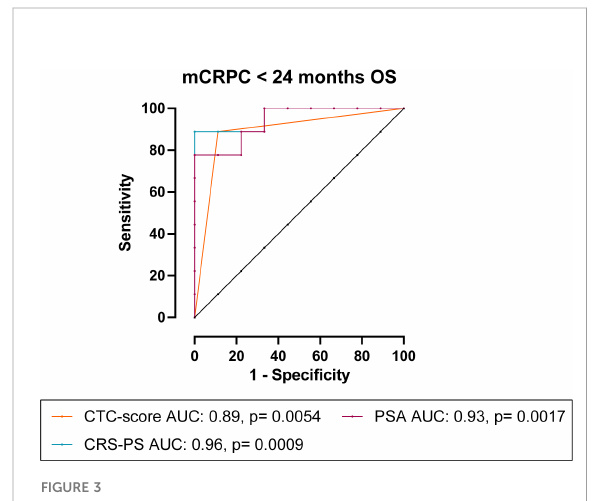
FIGURE 3 CRS of CTC-score and PSA for the prediction of <24 months OS in mCRPC patients. In mCRPC patients, combining CTC-score with PSA as CRS-PS= 0.08127 * PSA + 4.159 * CTC-score, increased the AUC to 0.96, p=